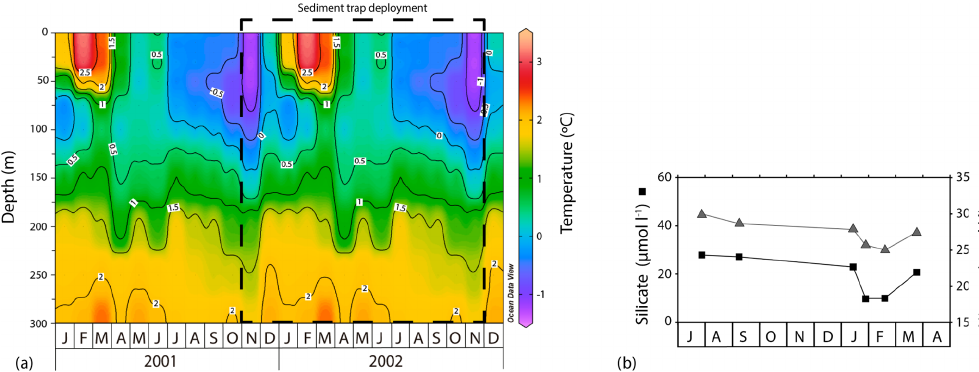
Figure 2. (a) Seasonal variation in the vertical structure of temperature ( ◦ C) between January 2001 and December 2002 for the 61 ◦ S site from the World Ocean Atlas 2009 (Locarnini et al., 2010). (b) Summary of seasonal evolution of macronutrient concentrations (silicate and nitrate) in the mixed layer at the 61 ◦ S site taken from the WOCE SR3 transects between 1993 and 1996 (modified from Trull et al.,